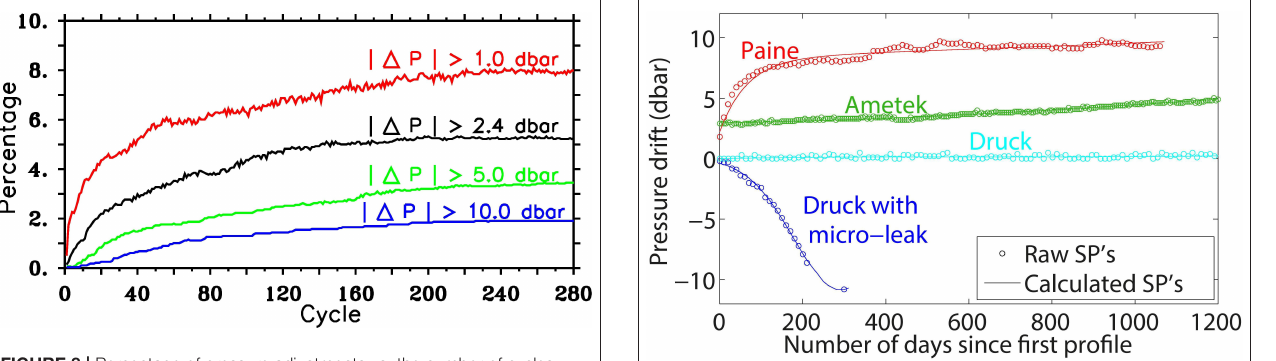
FIGURE 9 | Typical SP offsets (dbar) for pressure sensors: Paine (WMO ID 56501), Ametek (WMO ID 2900089), Druck (WMO ID 3900263), and a Druck microleaker (WMO ID 5901649). [Source: from (Barker et al., 2011). Copyright 2011 American Meteorological Society